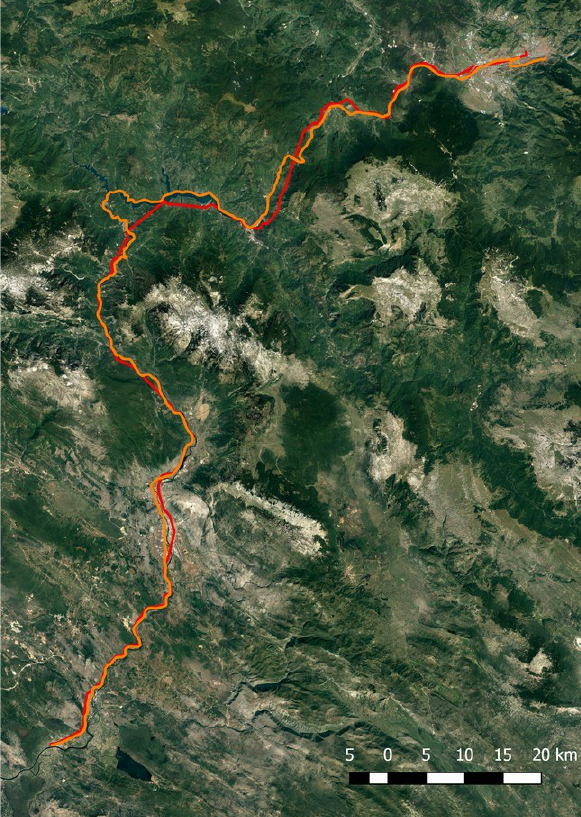
Figure 4. Different railway tracks from Sarajevo to Metkovic (Satellite images: Google Maps ©2017